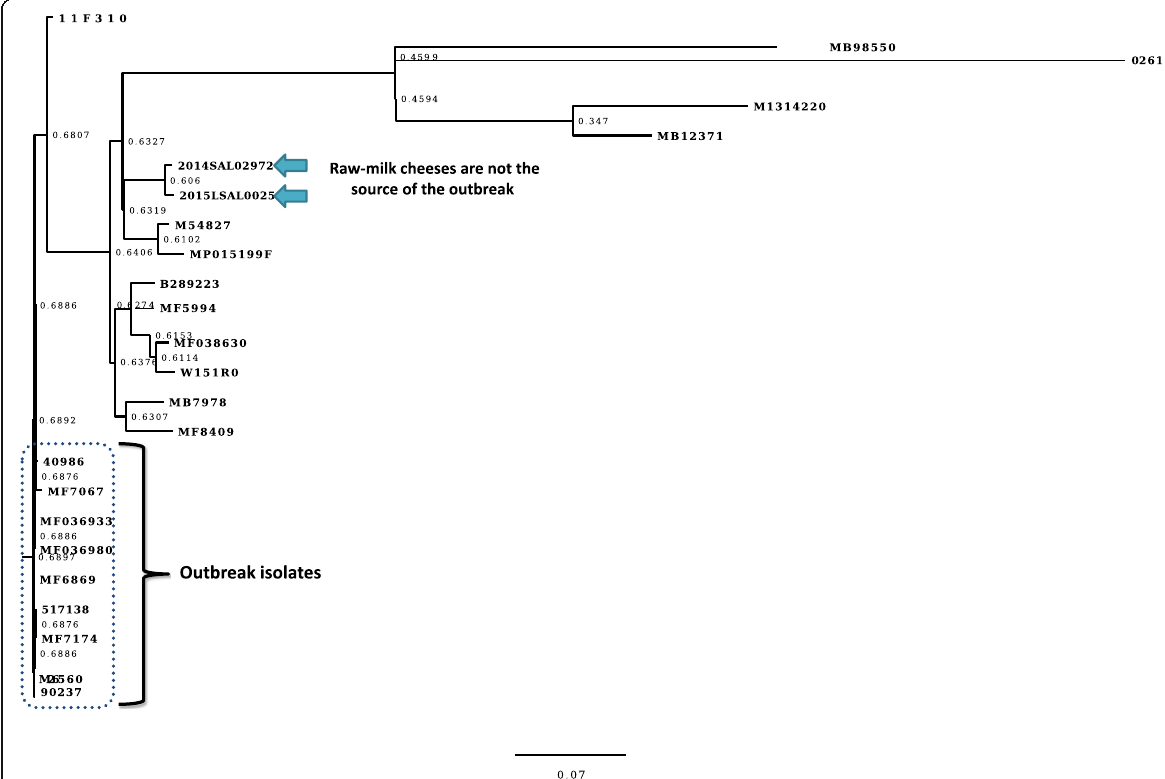
Fig. 2 Maximum likelihood phylogenetic tree of Salmonella Dublin strains based on single nucleotide polymorphisms determined from whole genome sequences. The scale represents the number of nucleotide substitutions per site. Bootstrap support values, given as a percentage of 1000 replicates, are shown on the branches. All Salmonella Dublin isolates had indistinguishable pulsed-field gel electrophoresis